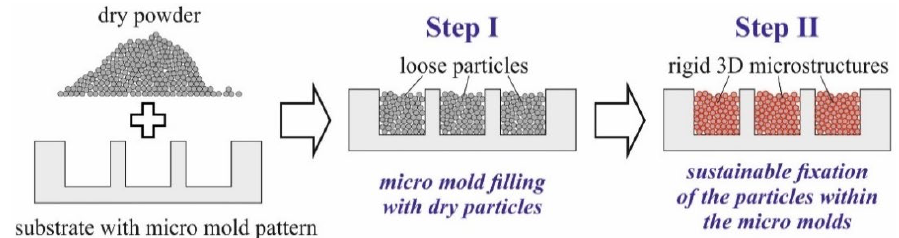
Figure 1. The fabrication of rigid 3D microstructures from dry micron-sized powder on a planar substrate with micro mold pattern basically comprises two steps. Step I: fill spreading of dry powder